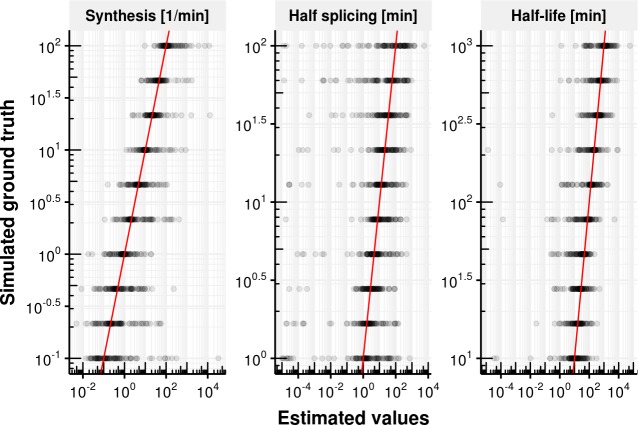
Evaluation of coupled model fitting.Estimated synthesis rate α, splicing half-time (log2βA) and junction bond half-life (log2βJ) on the x-axis vs. simulated ground truth synthesis rate, splicing half time and half-life time. The red line shows the identity. Most estimates are unbiased but show a high degree variation.